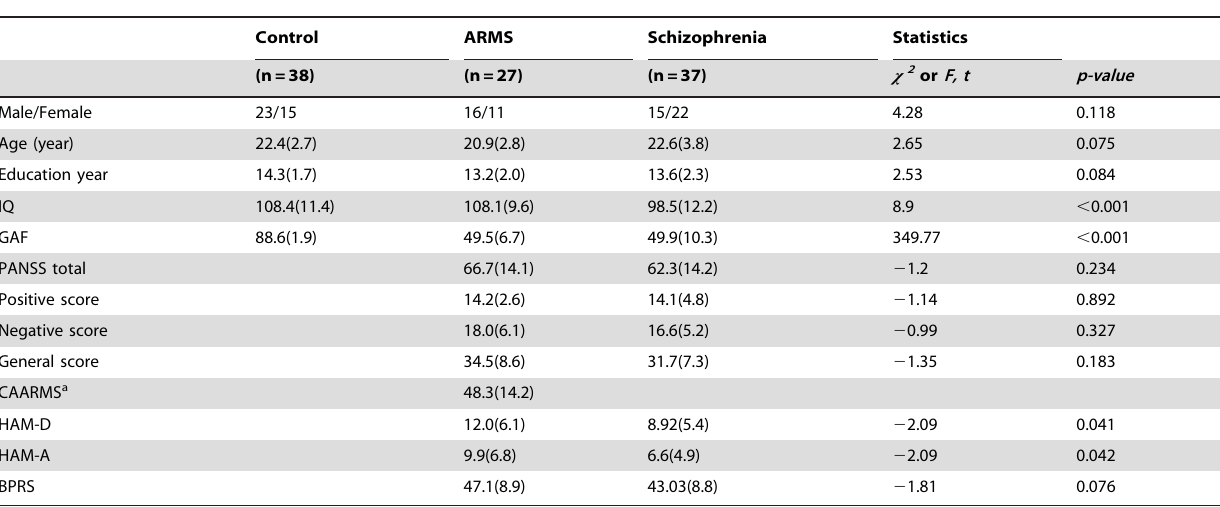
Table 1. Demographic and clinical